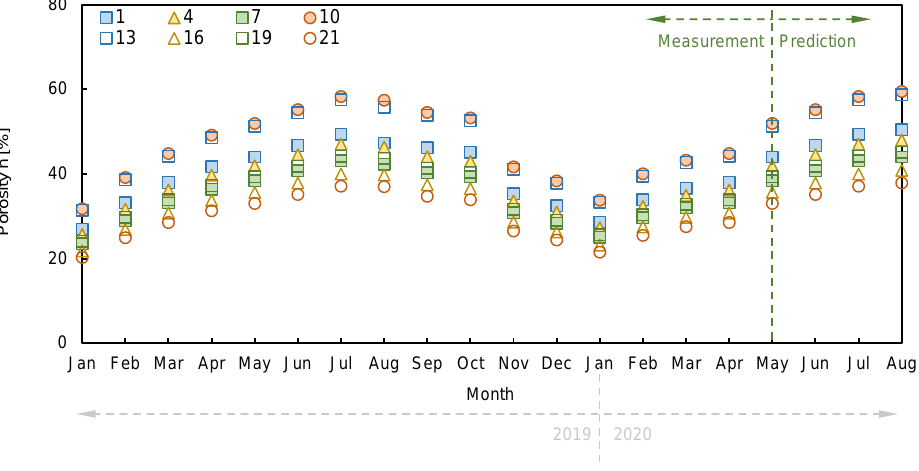
Figure 11. Distribution of porosity according to a time series.